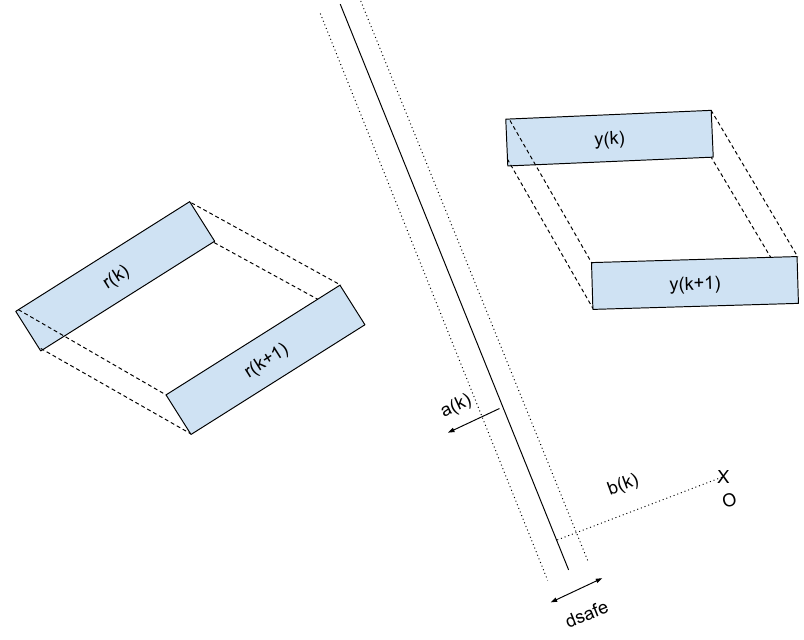
Figure 2. An illustration of separating plane between two